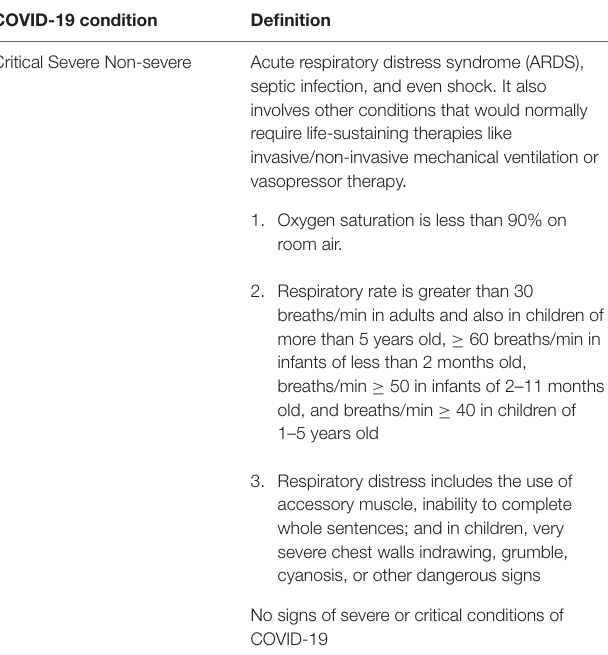
TABLE 2 | Different categories of disease severity during COVID-19 according to WHO guidelines. COVID-19